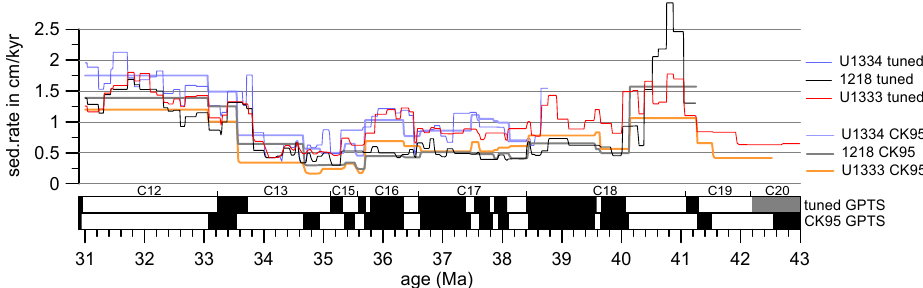
Figure 8. Sedimentation rate estimate in cmkyr − 1 based on astronomical tuning compared with paleomagnetic based estimates using the timescale of Cande and Kent (1995, CK95). For reference the CK95 and tuned GPTS (this study) are drawn.